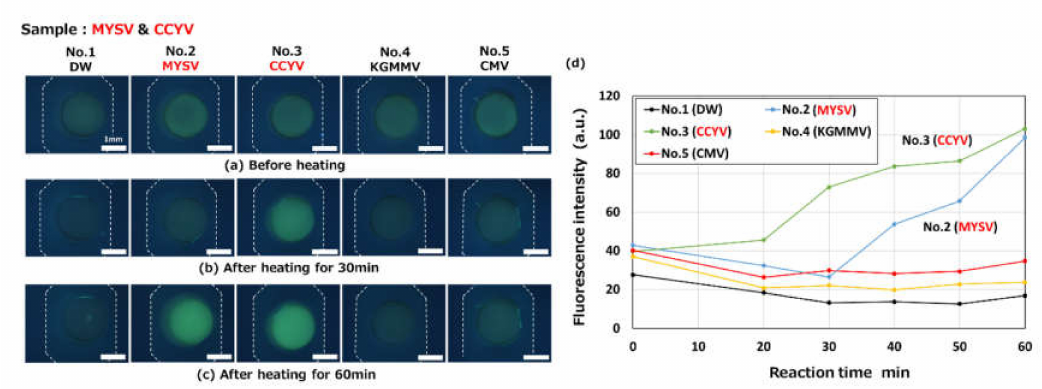
Figure 17. Fluorescence microscopy images showing the simultaneous RT-LAMP detection of multiple RNA-based plant viruses (MYSV and CCYV) observed ( a ) before heating and after heating for ( b ) 30 min and ( c ) 60 min at 63 ◦ C (taken with an optical filter BV-2A, gain: 1 × , exposure time: 2 s). Primer sets for the detection of MYSV and CCYV were pre-spotted in reaction chamber Nos. 2 and 3, respectively. ( d ) Changes in fluorescence intensities as a function of the reaction time. The concentrations of total RNA, containing the MYSV and CCYV viral RNA targets, were 11.1 and 9.6 ng / µ L, respectively, after mixing with the LAMP reagents.